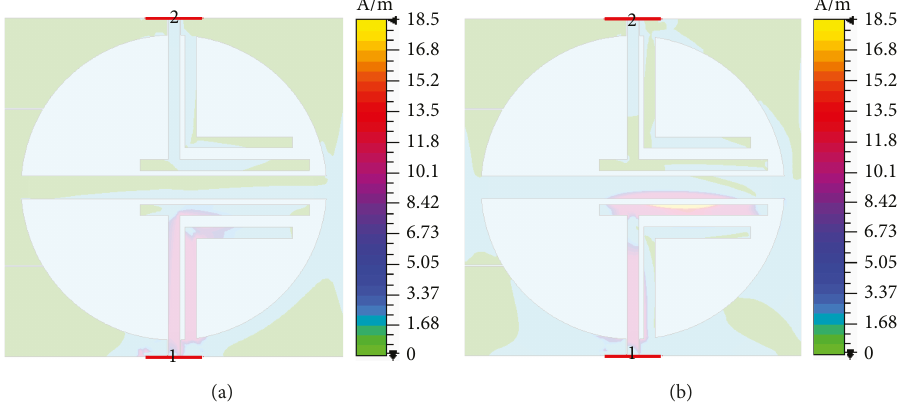
Figure 4: Current distribution of the proposed antenna with the isolation structure (a) at 0.75GHz and (b) at